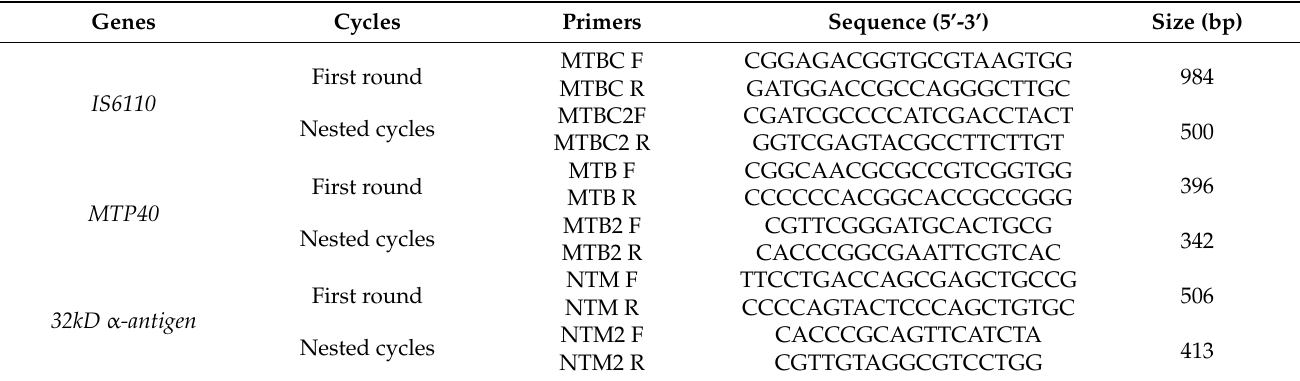
Table 1. Sequences of primers used in nested multiplex PCR for the detection of Mycobacterium species. Genes